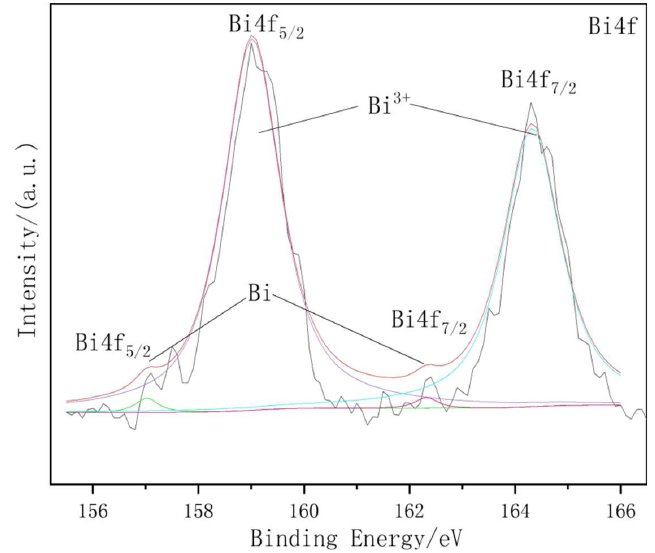
Figure 5. XPS spectrum of Bi4f for Mg–8%Al–0.4%Bi alloy discharged at 120 mA/cm 2 for 30 min.